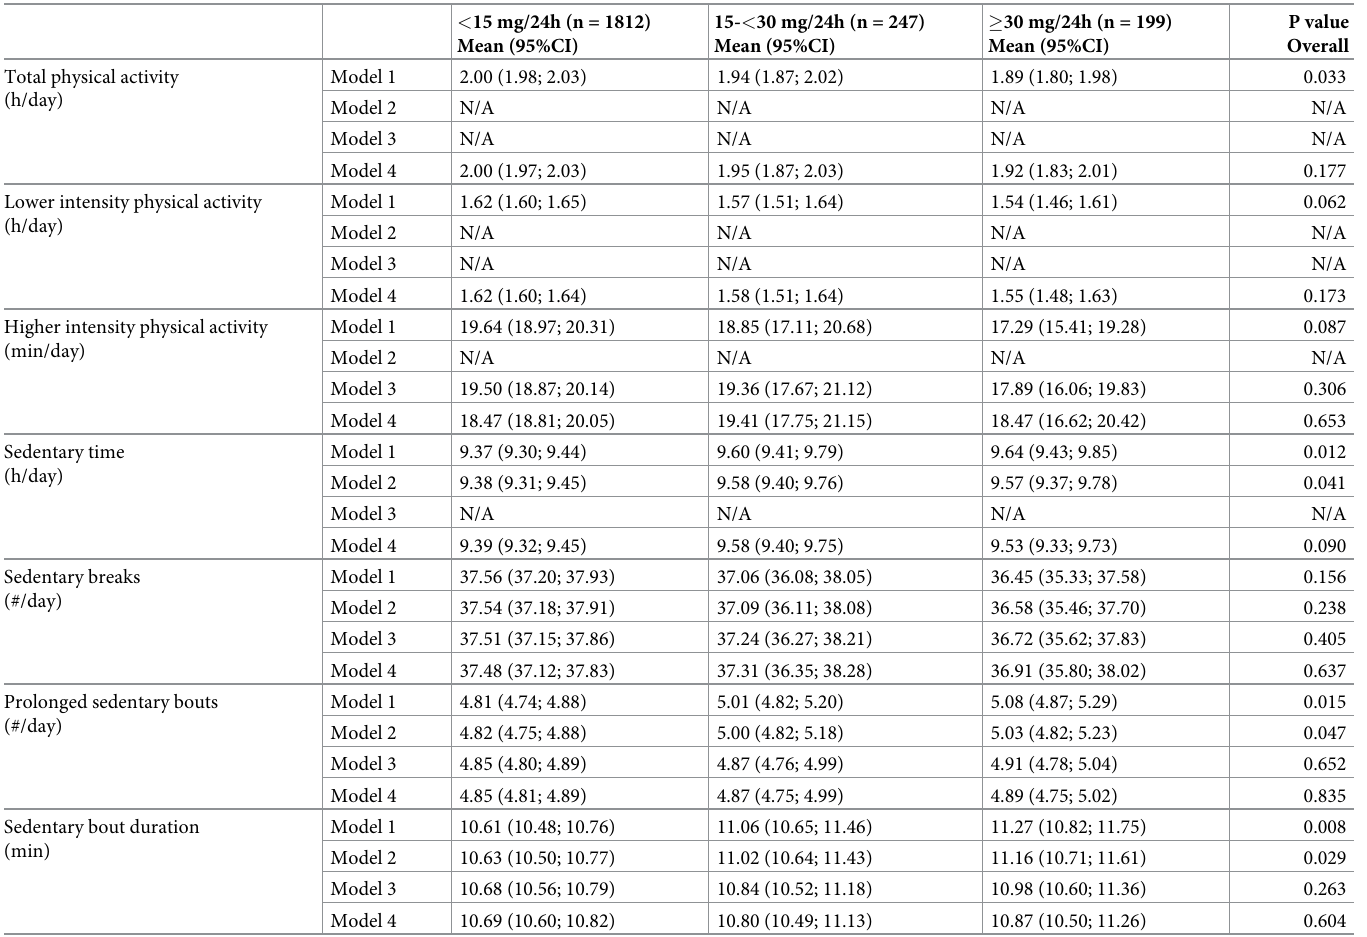
Table 4. Adjusted means of physical activity and sedentary behavior variables according to albuminuria categories.